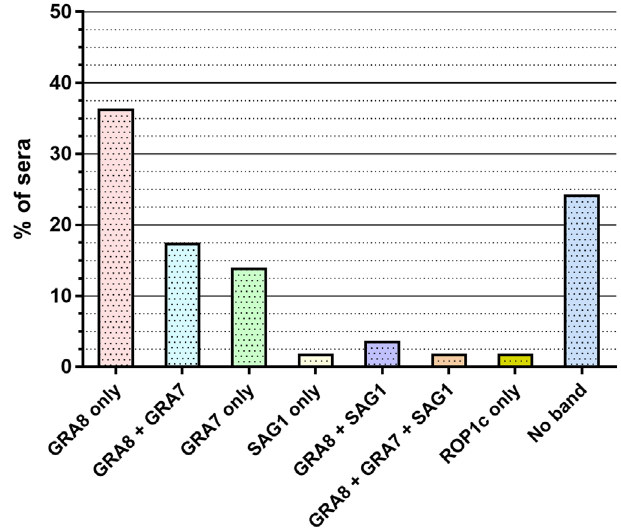
Figure 2. Description of the recom Line (cid:1) immunoblot pro fi les (for the 58 negative LDBio (cid:1) tests considered true false-positive sera with Architect (cid:1)